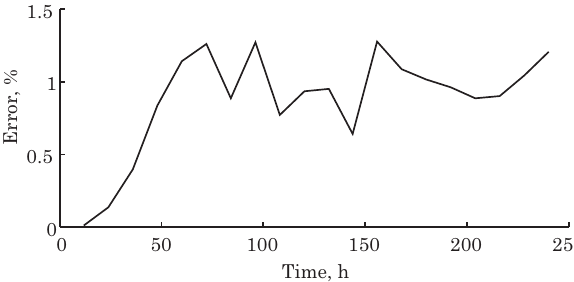
Figure 8. Behavior of Percent Error as a function of